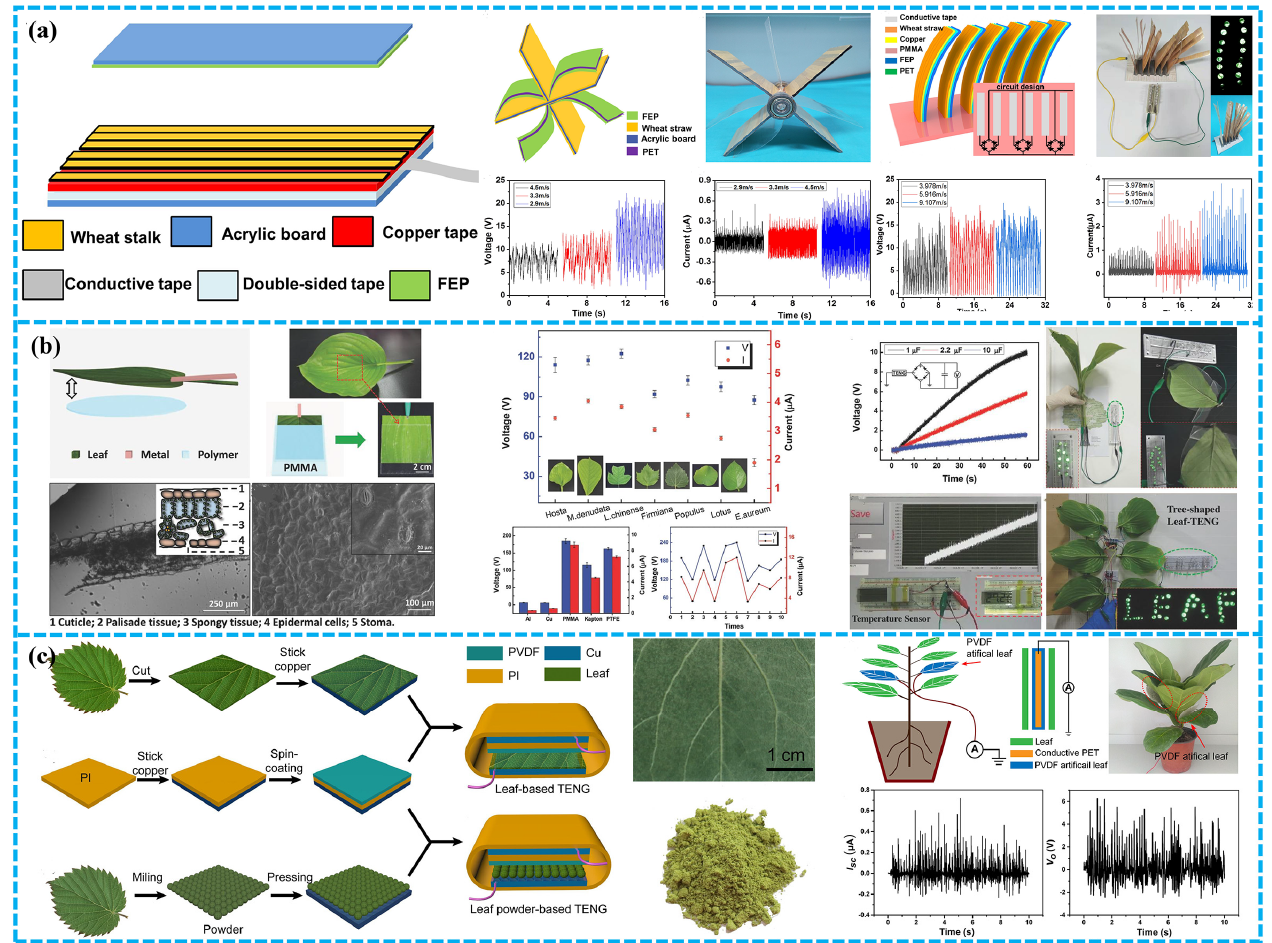
Figure 6. Plant-based BD-TENGs. ( a ) Structure of natural wheat straw assembled TENG; structural diagram of windmill and structural diagram of WS-TENG lawn and various output performance.